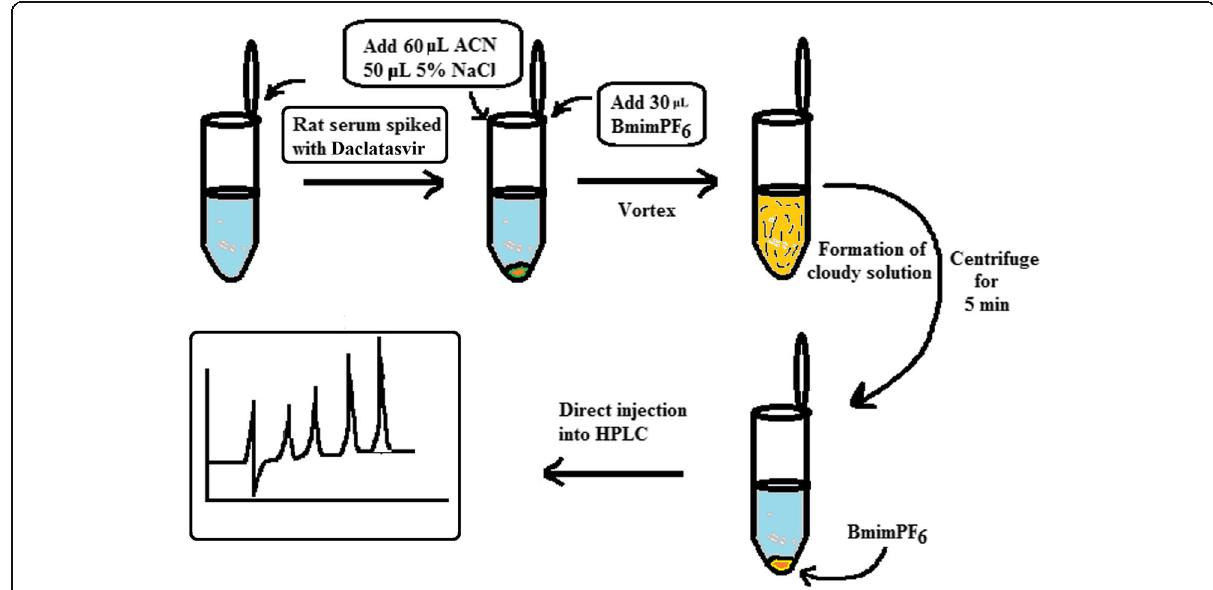
Fig. 2 Schematic representation of vortex-assisted an IL-based DLLME of